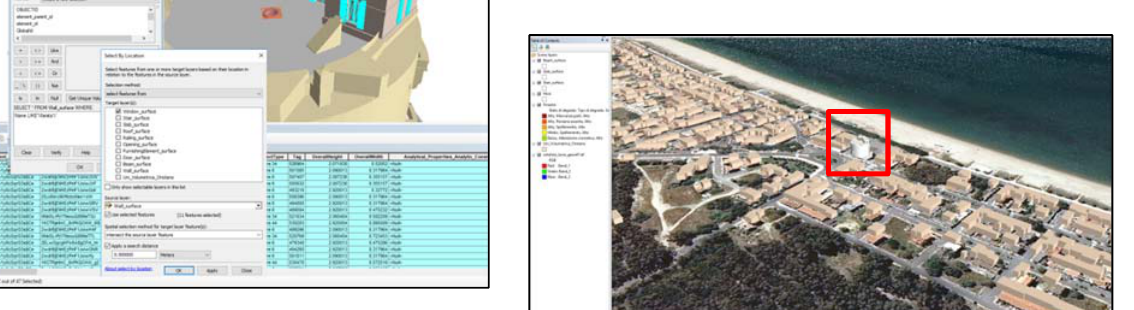
Figure 10. The parametric model in the urban